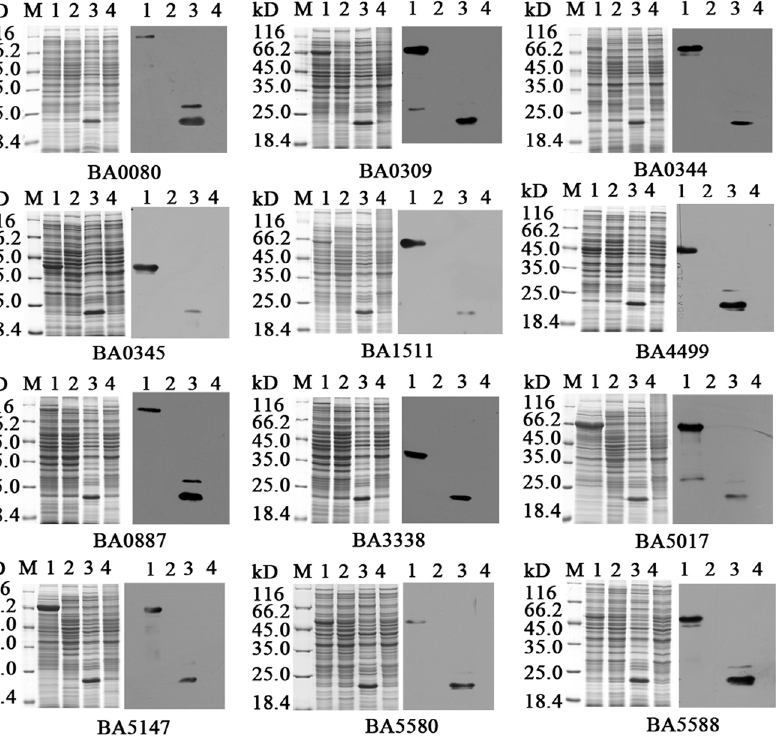
Figure 3. Expression of the 12 immunoproteins. The left panels are the SDS-PAGE maps and the right panels are the western blot assay with His-tag monoclonal antibody (HRP-conjugated). (1) Proteins of interest after induction; (2) proteins of interest before induction; (3) vector after induction; (4) host cell BL21. M: Unstained protein molecular weight marker (Fermentas).